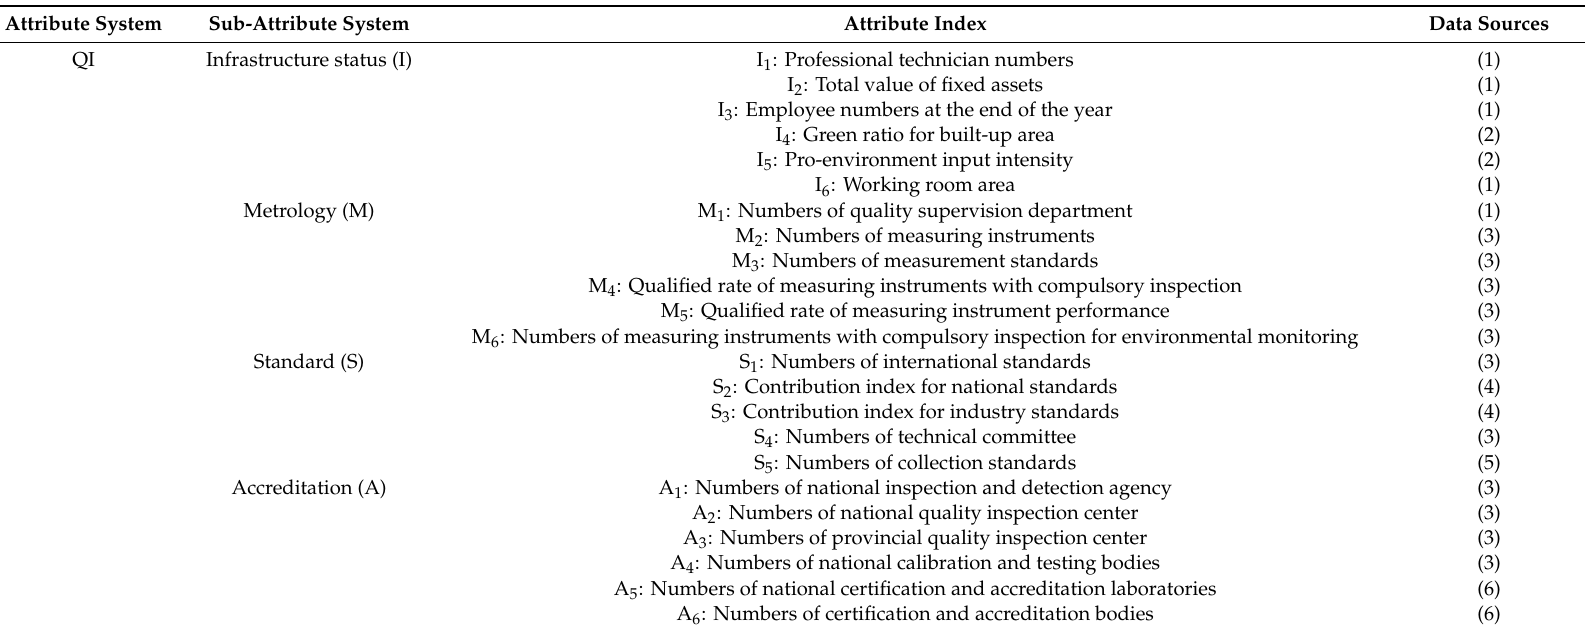
Table 1. The index system of